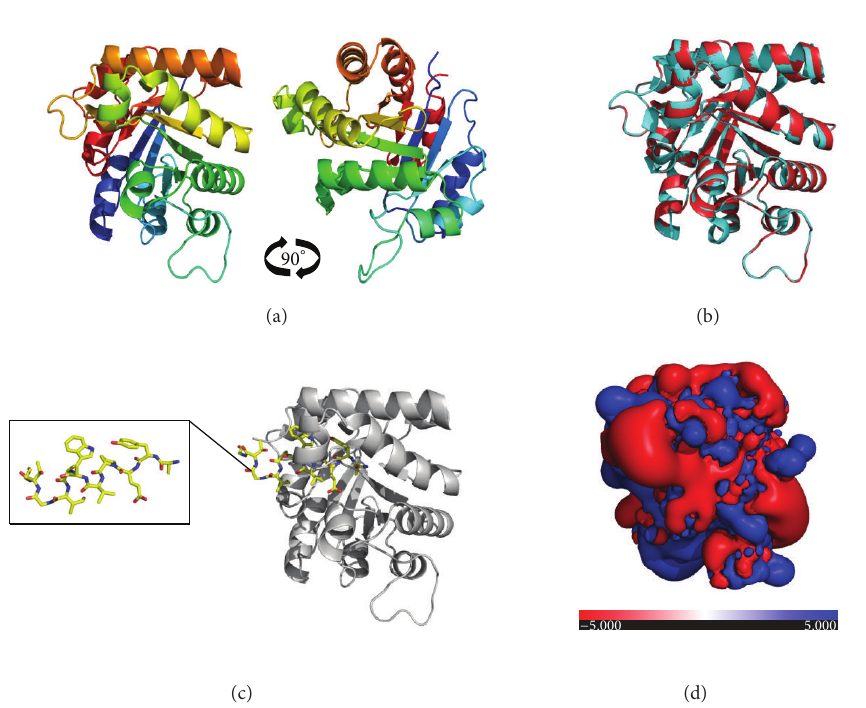
Figure 3: Structural analysis of Der f 25. (a) Protein structure of Der f 25 homology model. (b) Superimposition between Der f 25 and 2I9E template.Derf25isdepictedinredand2I9Etemplateisdepictedincyan.(c)DistributionofcharacteristicpatterninDerf25.(d)Electrostatic potential representation on the Der f 25 protein